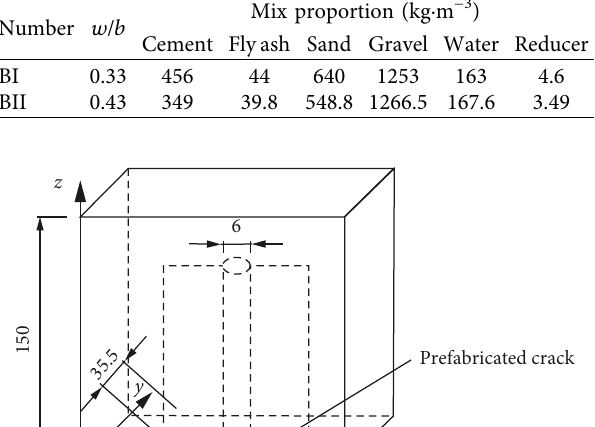
Table 1: Concrete mixture.